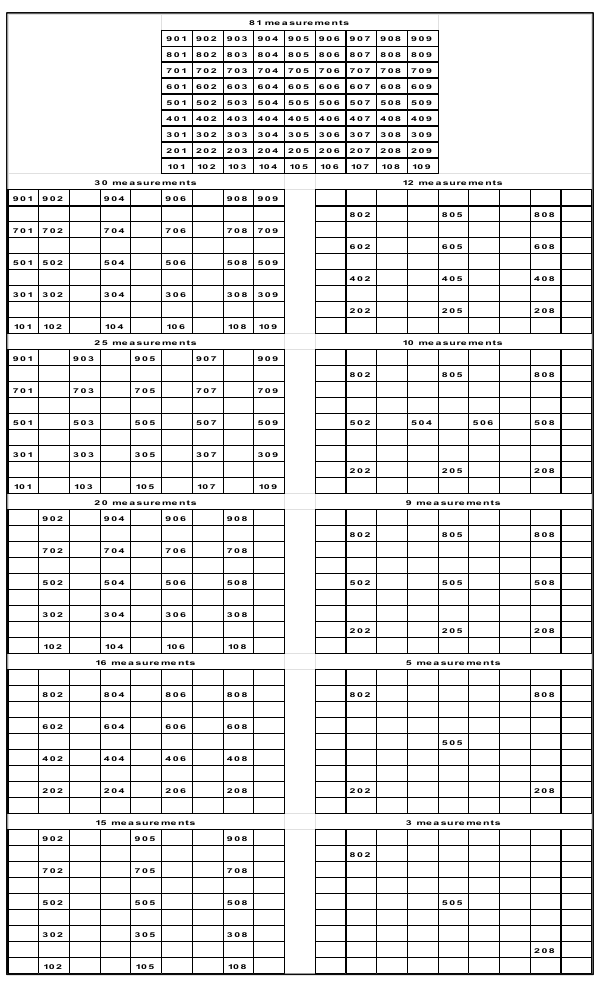
Figure 3. At the study site, 81 plots were identified by individual plot numbers, with plots shown (in bold) where rootzone volumetric water content was measured. Individual plot size was 2.1 m × 2.1 m and arranged in a square grid pattern of 9 plots × 9 plots, for a total of 81 plots that measured 368.7 m 2 .